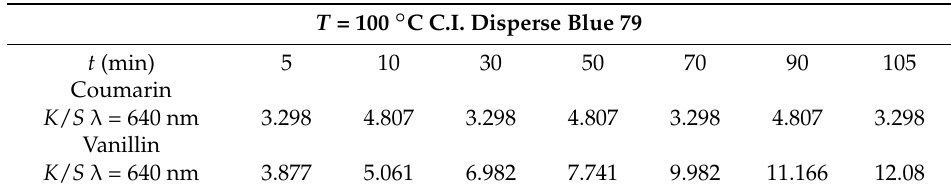
Table 4. K / S values for PES fabric dyed with D79 in presence of 0.666 g · L –1 of coumarin or o -vanillin at 100 ◦ C and different times (5, 10, 30, 50, 70, 90 and 105 min).